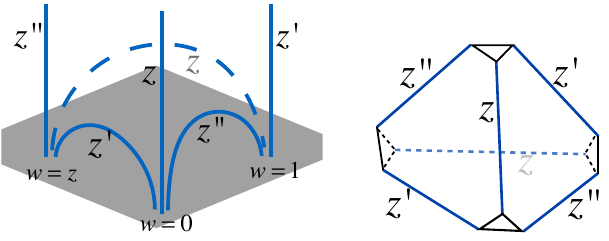
Figure 2 . Edge parameters ( z; z 0 ; z 00 ) of an ideal tetrahedron. Left: ideal tetrahedron in H 3 = f ( y; w ) : y 2 R C g with metric ds 2 ( H 3 ) = dy 2 + dwd (cid:22) w . Using the isometry of H 3 , + ; w 2 y 2 PSL(2 ; C ), four asymptotic vertices can be placed at ( y; w ) = (0 ; 0) ; (0 ; 1) ; (0 ; z ) and ( 1 ; (cid:1) ). Right: topologically, ideal tetrahedron is a tetrahedron with truncated